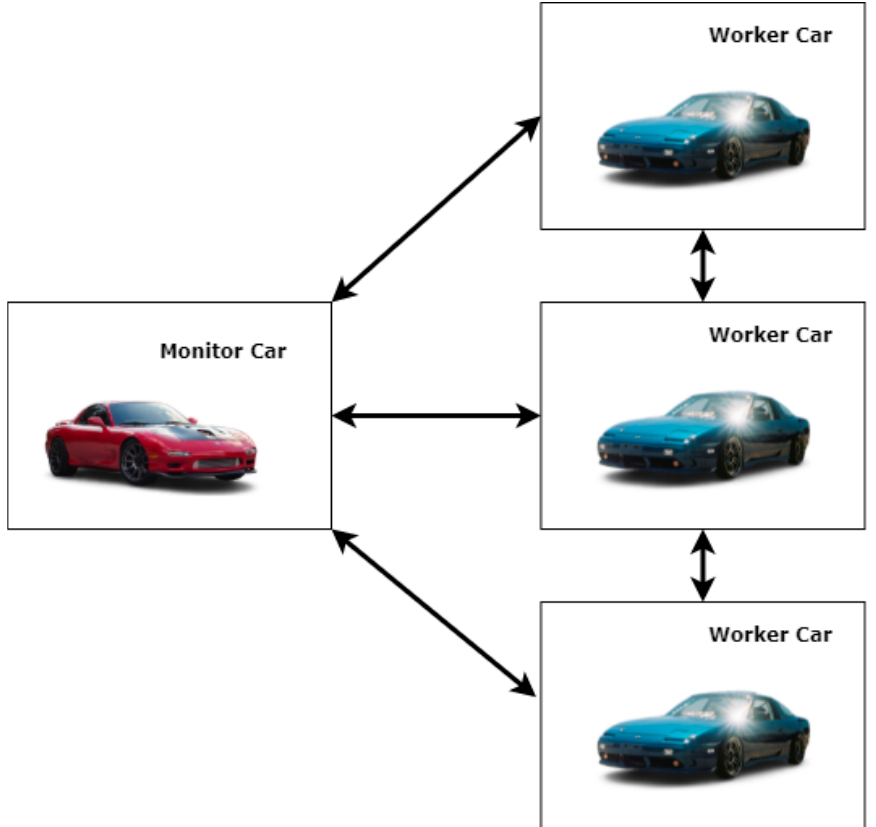
Figure 4. High-level implementation of the proposed vehicular distributed system implementa- tion.